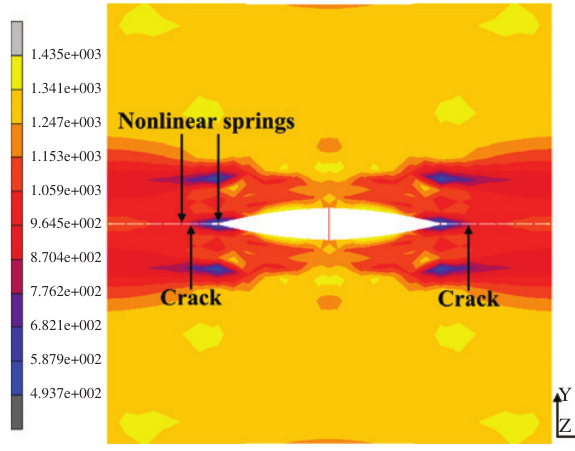
Figure 14: X -component stress distribution of the cell.